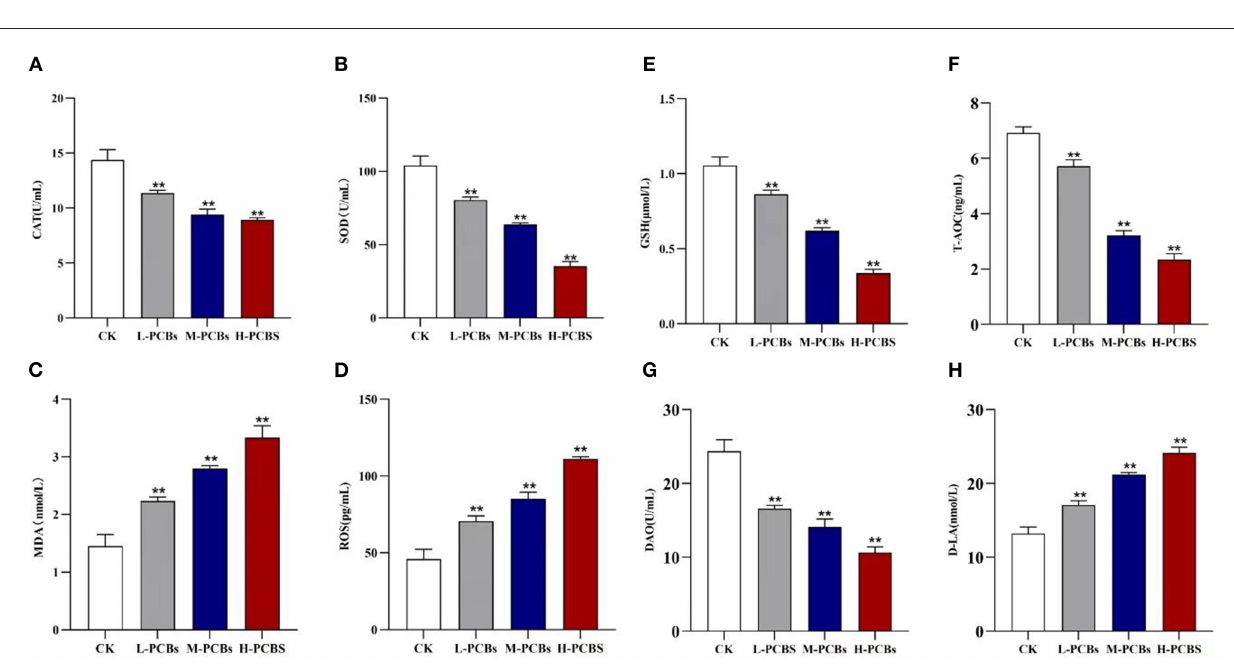
FIGURE 2 | Change map [ (A) . CAT (B) .SOD (C) . MDA (D) . ROS (E) .GSH (F) . T-AOC (G) . DAO (H) . D-LA, * P < 0.05, ** P < 0.01 compared to control